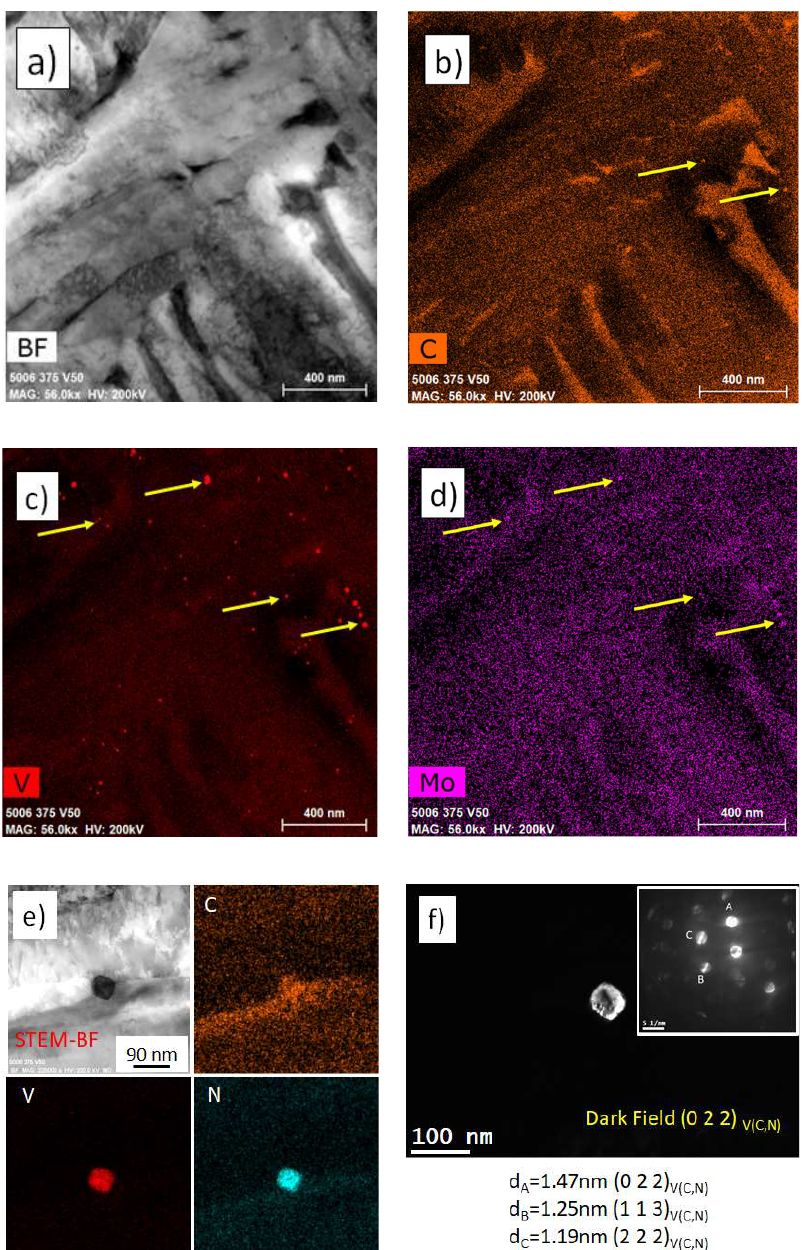
Figure 9. Ref+V alloy transformed at 375 °C, ( a ) STEM bright field image, ( b ) EDX carbon map, ( c ) EDX vanadium map, ( d ) EDX molybdenum map from the same region, ( e ) STEM bright field image and EDX maps of a V(C,N) particle and ( f ) STEM dark field imaging and convergent beam electron diffraction (CBED) pattern confirming the crystal structure of the particle in e).